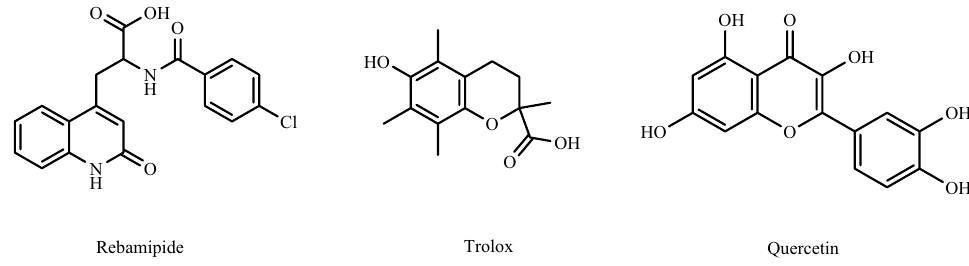
Figure 1. Chemical structures of antioxidant agents (Rebamipide, Trolox and Quercetin).